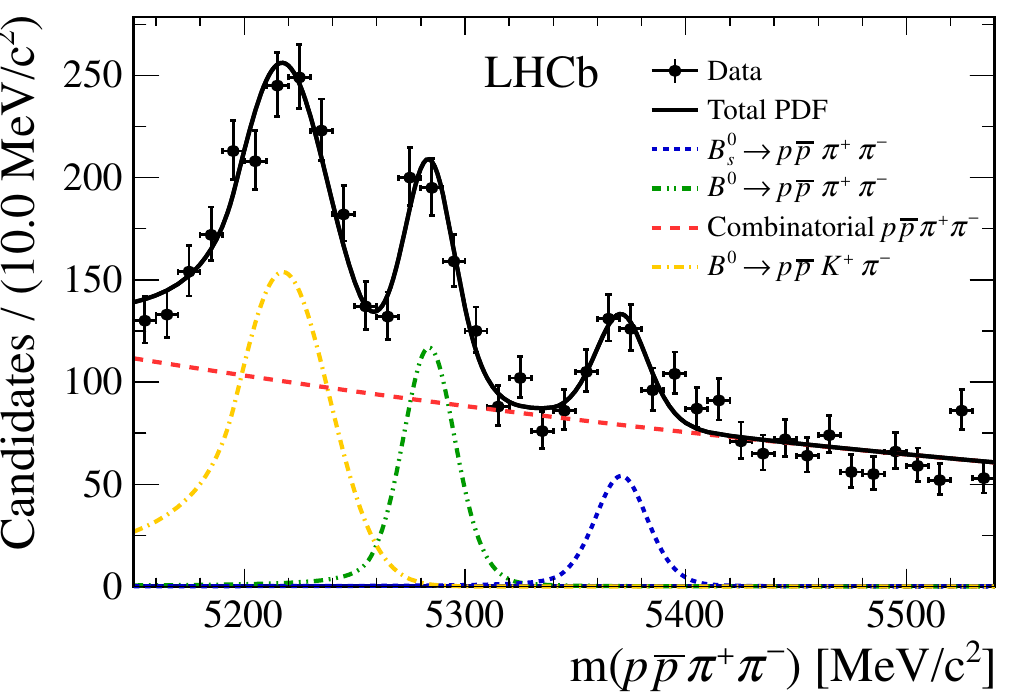
Figure 5 . Distribution of the p (cid:22) p(cid:25) + (cid:25) (cid:0) invariant mass. Points with error bars show the data. The solid curve is the projection of the total (cid:12)t result. The short-dashed blue, the dashed-double-dotted green, the dashed-single-dotted yellow and medium-dashed red curves show the B 0 B 0 ! p (cid:22) p(cid:25) + (cid:25) (cid:0) , B 0 ! p (cid:22) pK + (cid:25) (cid:0) and combinatorial background contributions,